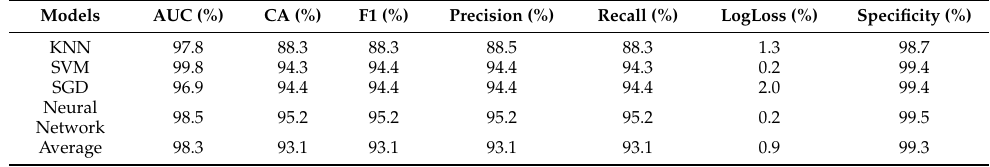
Table 4. Evaluation results for Ceiling Sensor (T2) data using K-Means Clustering Method (KMCM). Models